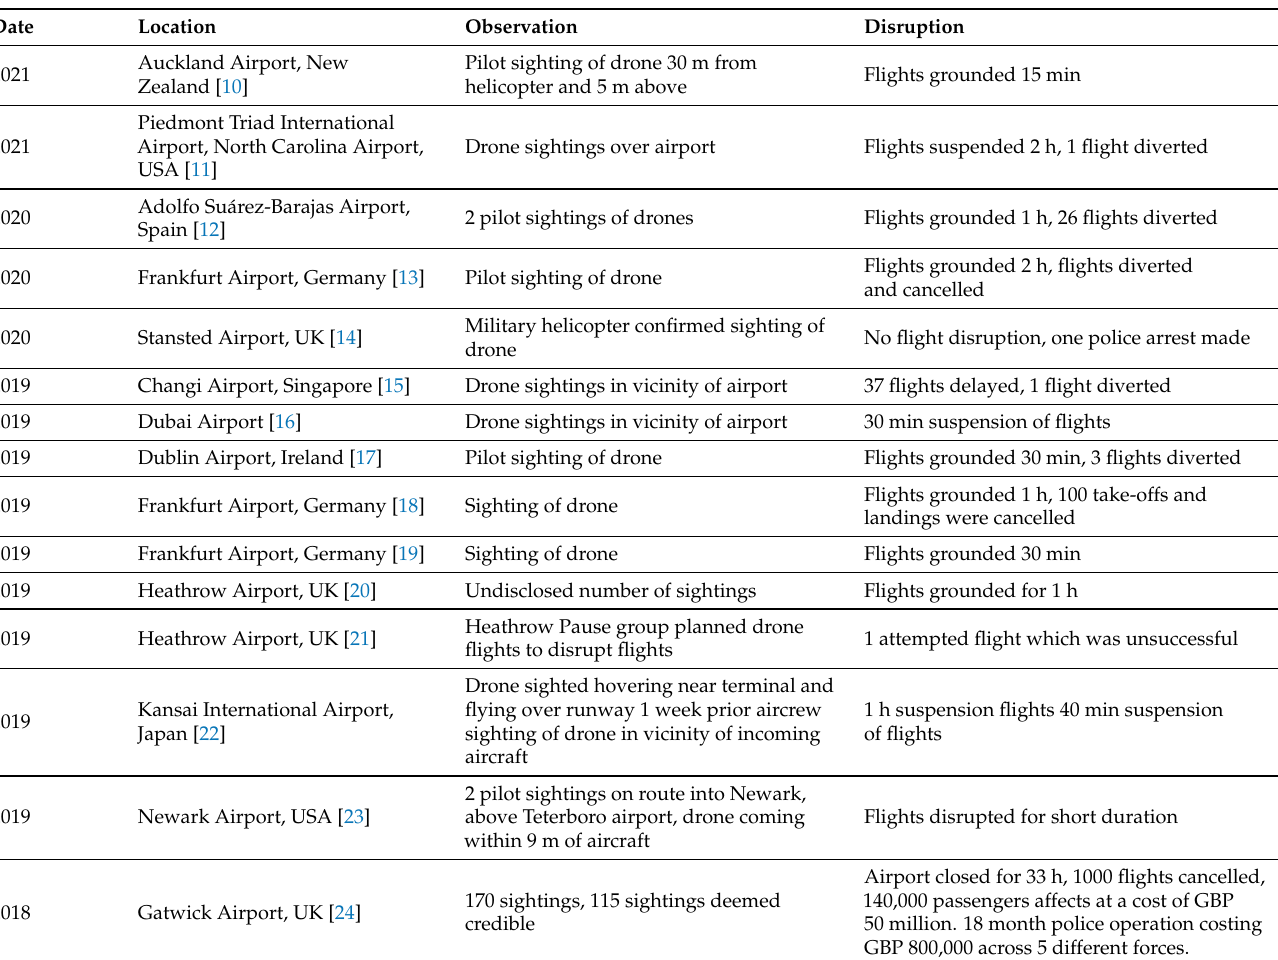
Table 1. UAS Airport